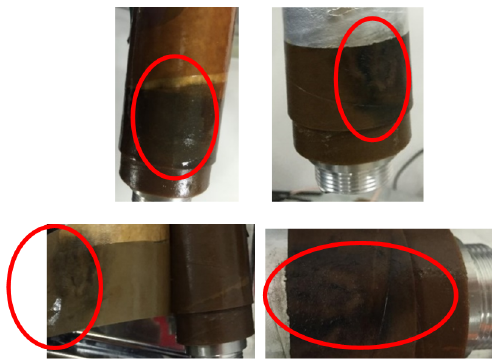
Figure 11. Path of discharge in OIP bushing.